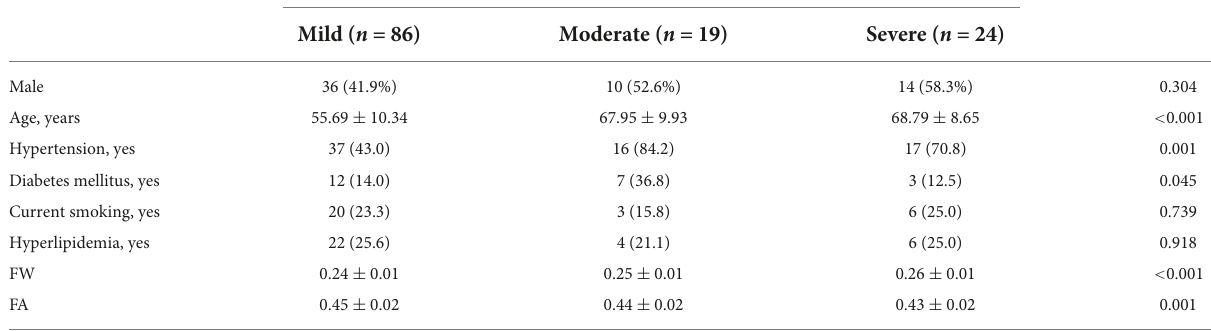
TABLE 2 Clinical and imaging features and comparison among participants according to burden of cerebral small vessel disease. Burden of cerebral small vessel disease